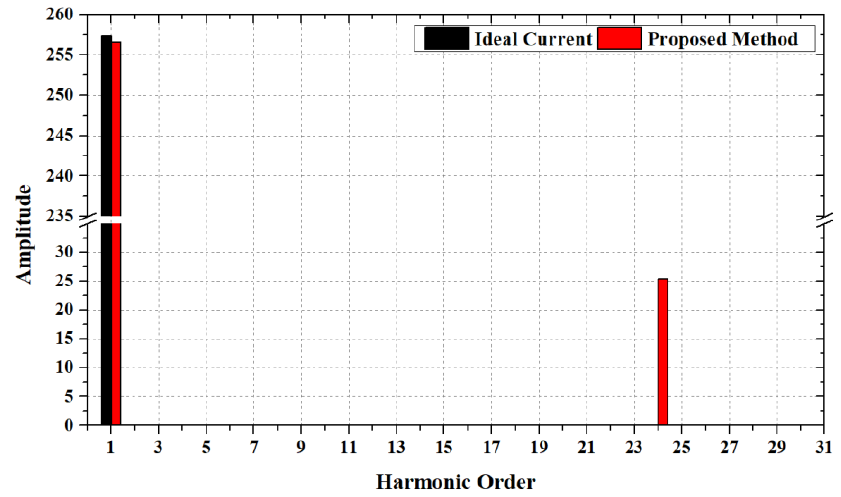
Figure 5. FFT plot of the ideal and harmonics injected currents.